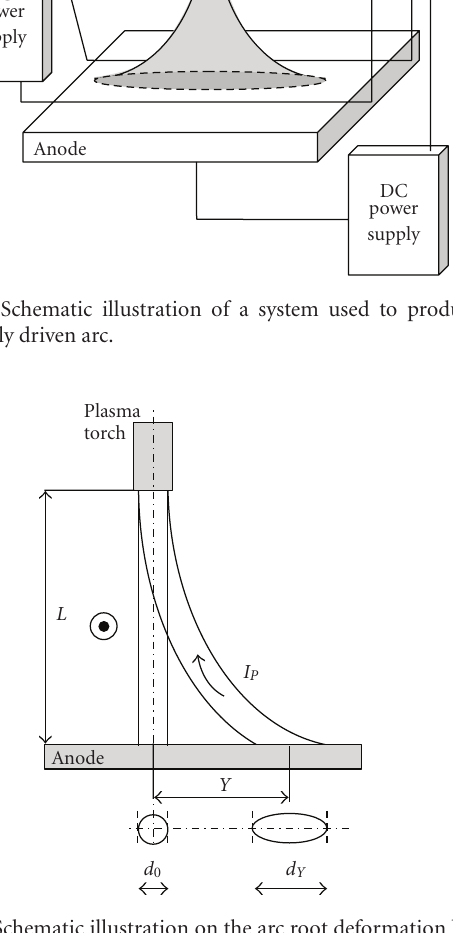
Figure 2: Schematic illustration on the arc root deformation by an imposed DC magnetic field.